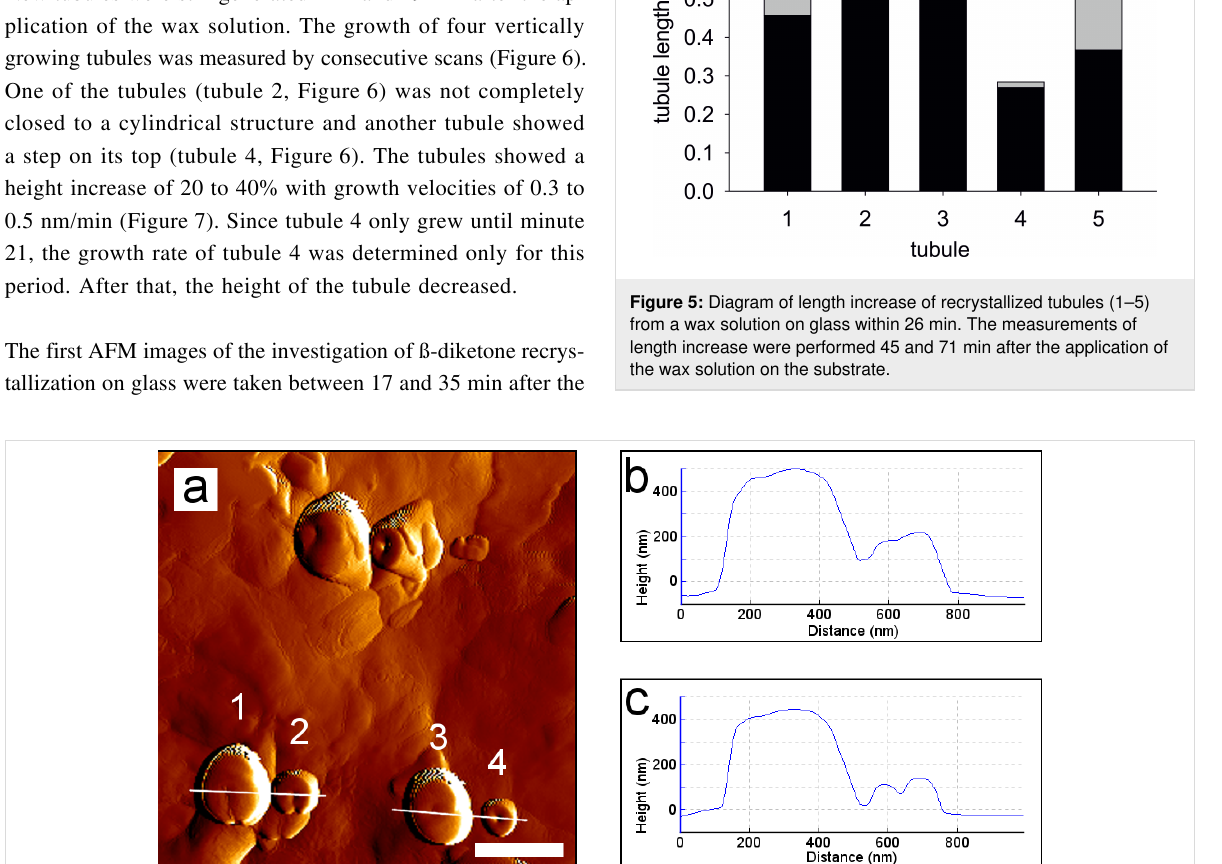
and Figure 4b). The length increase of five tubules was measured over 26 min. Within that time, the tubules had a varying length increase from 3 up to 300 nm (Figure 5).